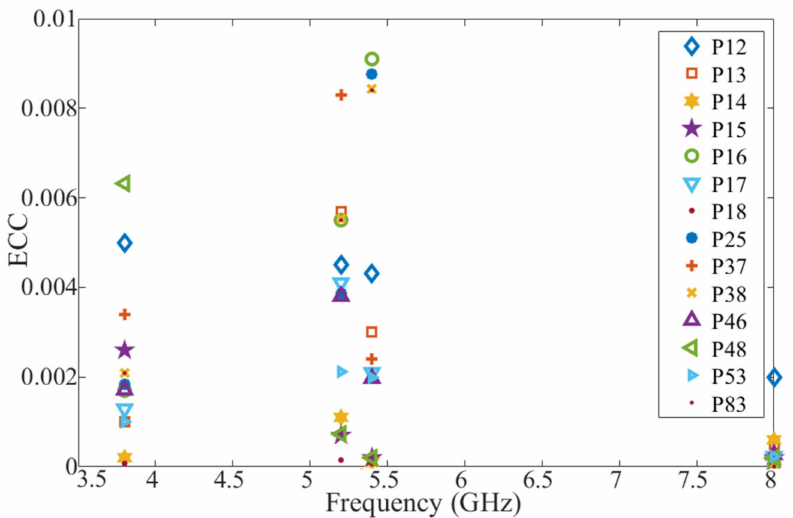
Figure 20. Envelope Correlation Coefficient (ECC) variation between different pairs of ports (e.g., P12: ECC between Port 1 and Port 2).